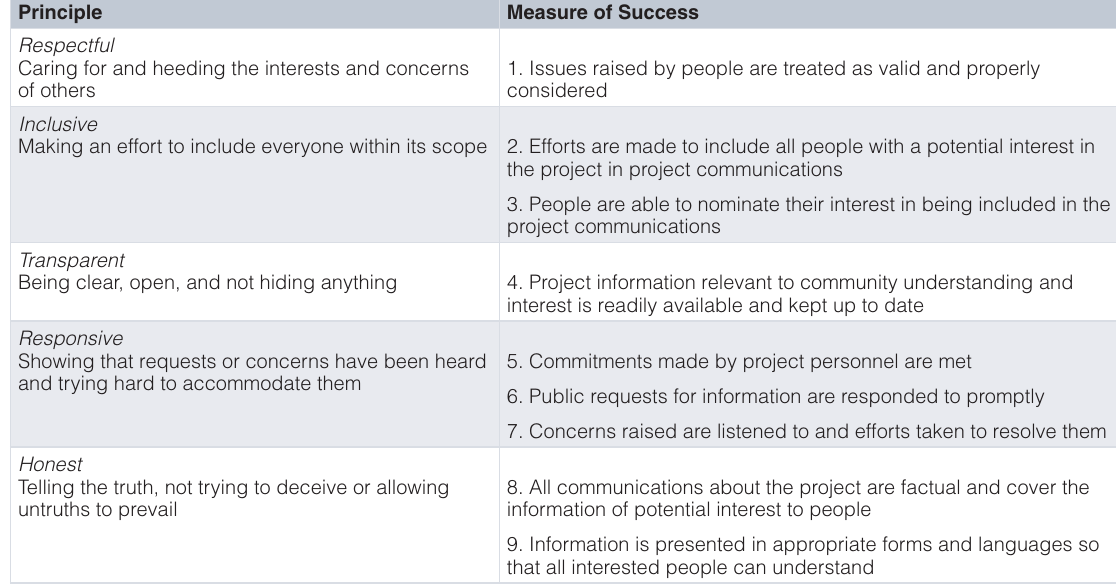
Table 1. Public participation principles of the World Mosquito community engagement approach.